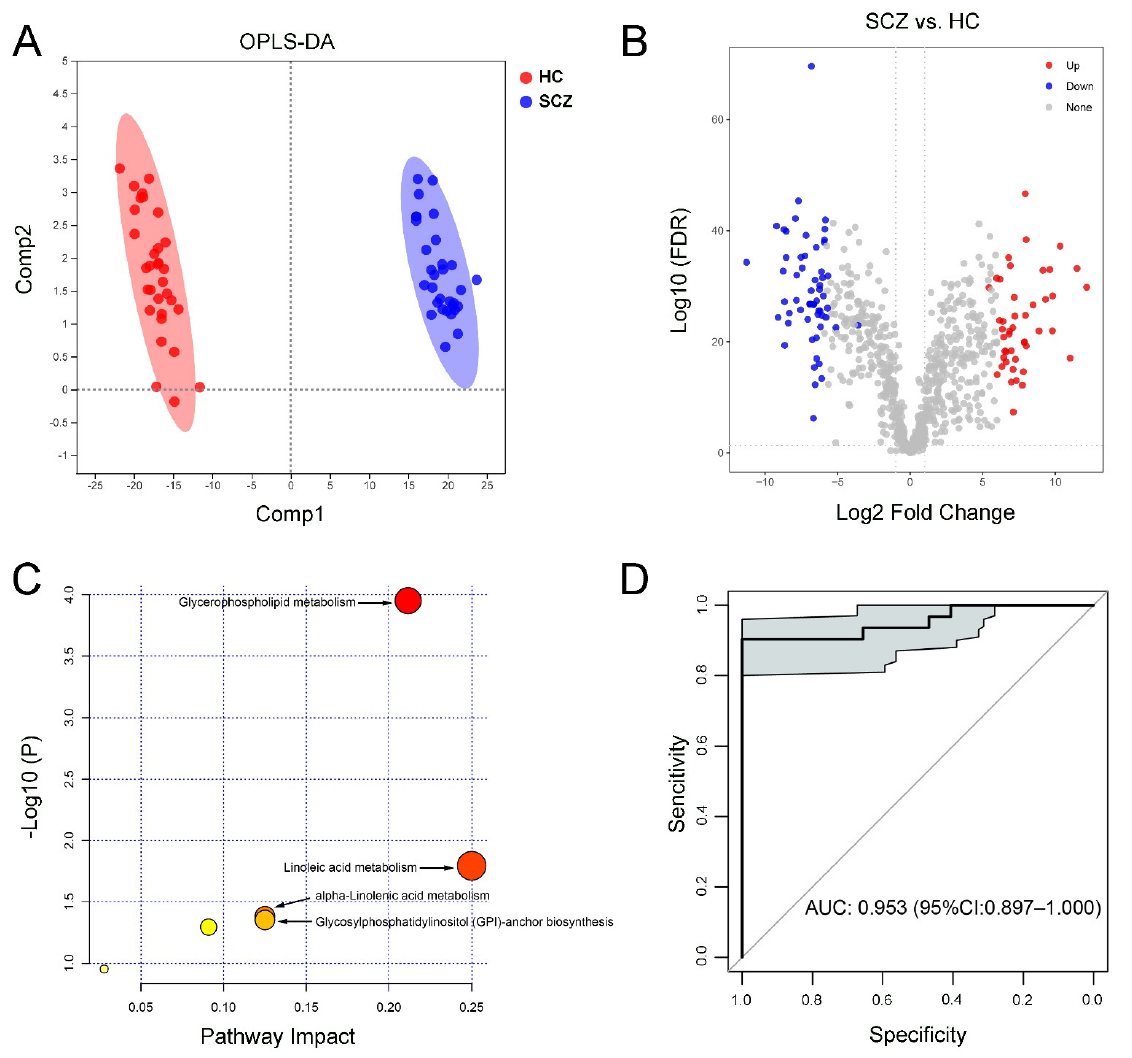
Figure 2. Differential lipid species and their functions between SCZ and HC. ( A ) OPLS-DA model for SCZ and HC, ( B ) volcano map showed the differential species (red dots indicated the increased lipid species and blue dots indicated the decreased lipid species) between SCZ and HC, ( C ) KEGG pathway enrichment analysis, and ( D ) ROC analysis for the combinational lipids.